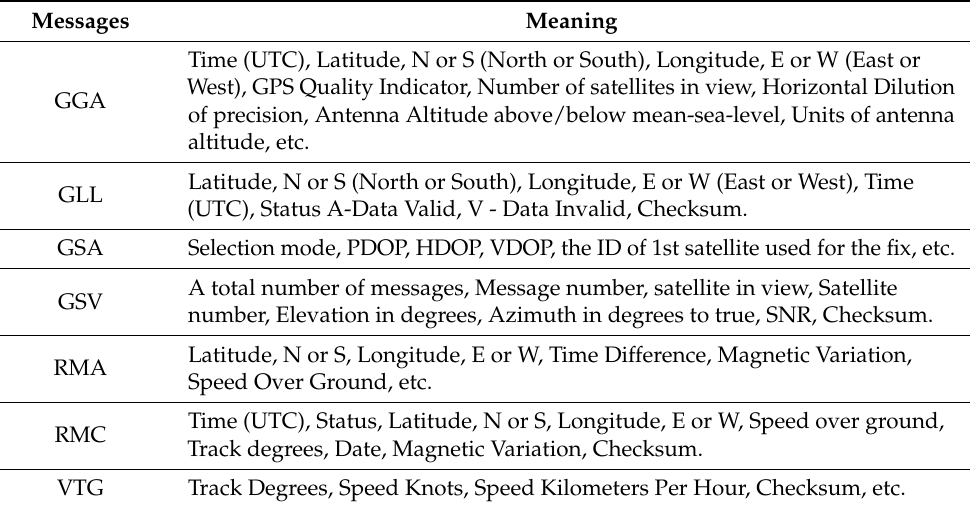
Table 1. Contents of various sentences in